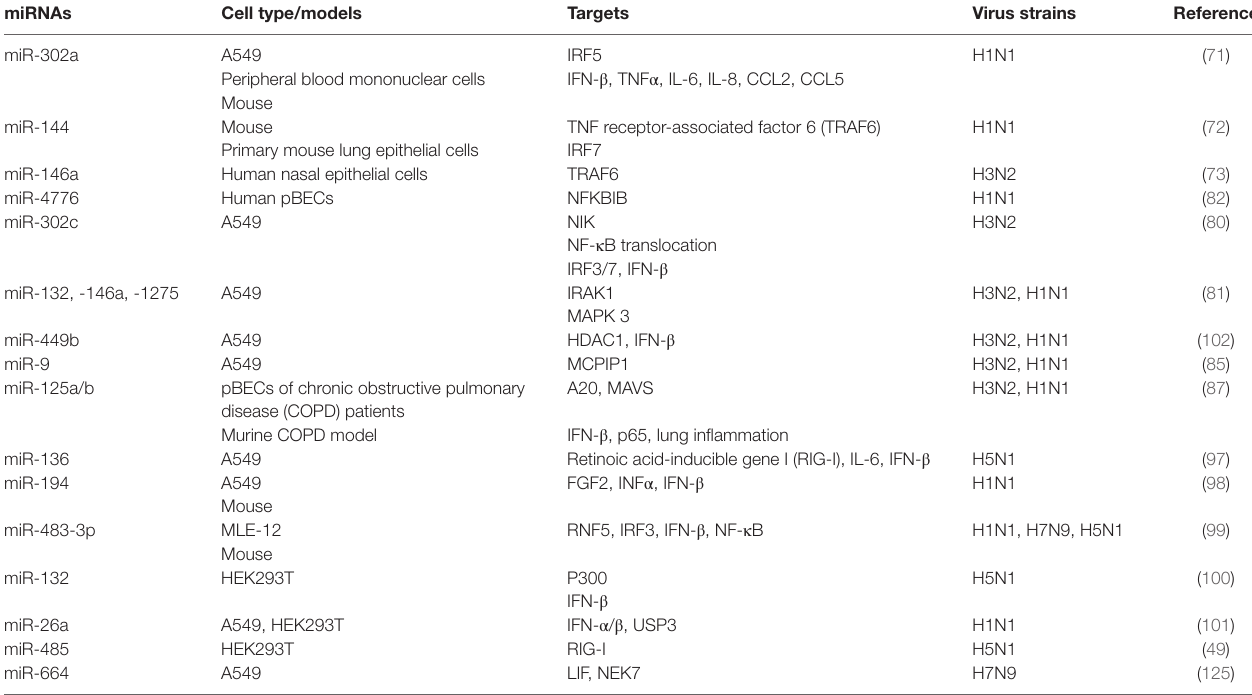
TAble 3 | MicroRNAs (miRNAs) control influenza A virus-induced inflammatory and antiviral responses.